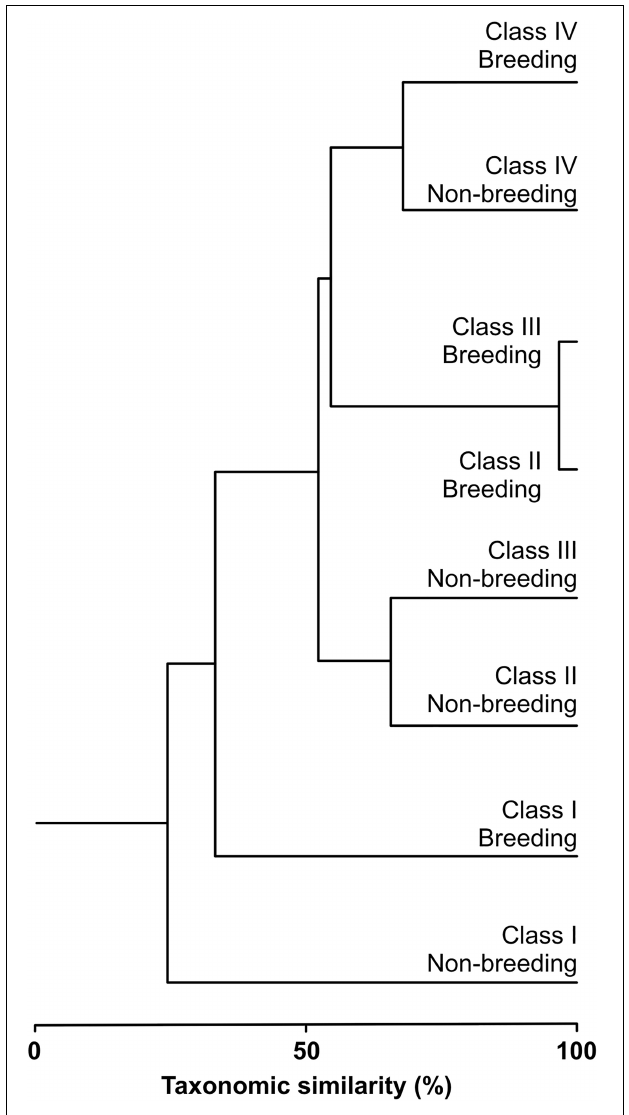
FIGURE 4 | Bray-Curtis abundance-based hierarchical cluster analysis including the four studied built cover classes of the city of Xalapa considering data for both years by season (breeding and non-breeding). Class I = 0–25% built cover, Class II = 26–50% built cover, Class III = 51–75% built cover, Class IV = 76–100% built